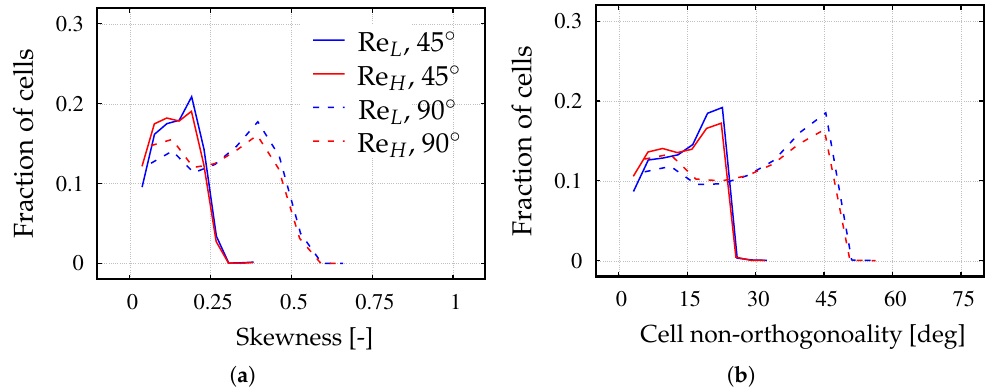
Figure 7. Distribution of the ( a ) equiangle skewness and the ( b ) non-orthogonality index. Higher is worse applies for both measures.